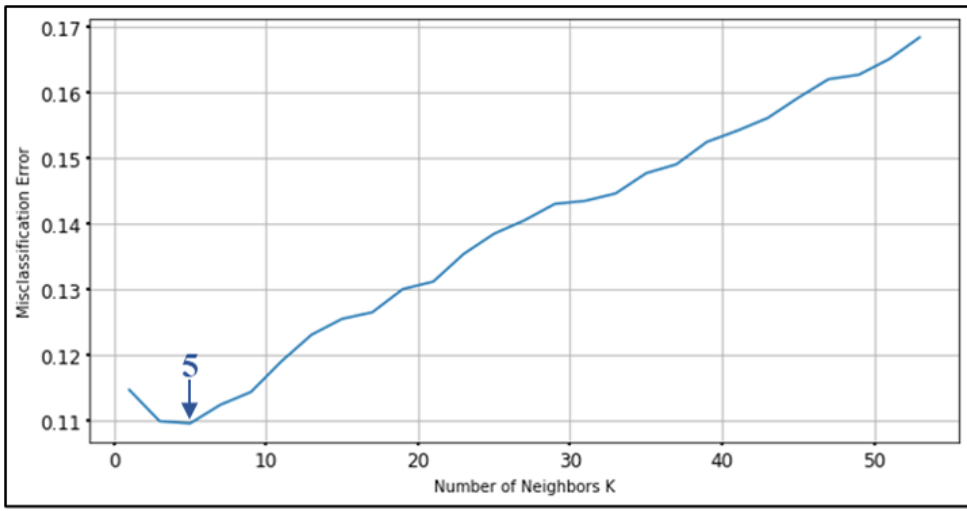
Figure 10. The results of k-fold